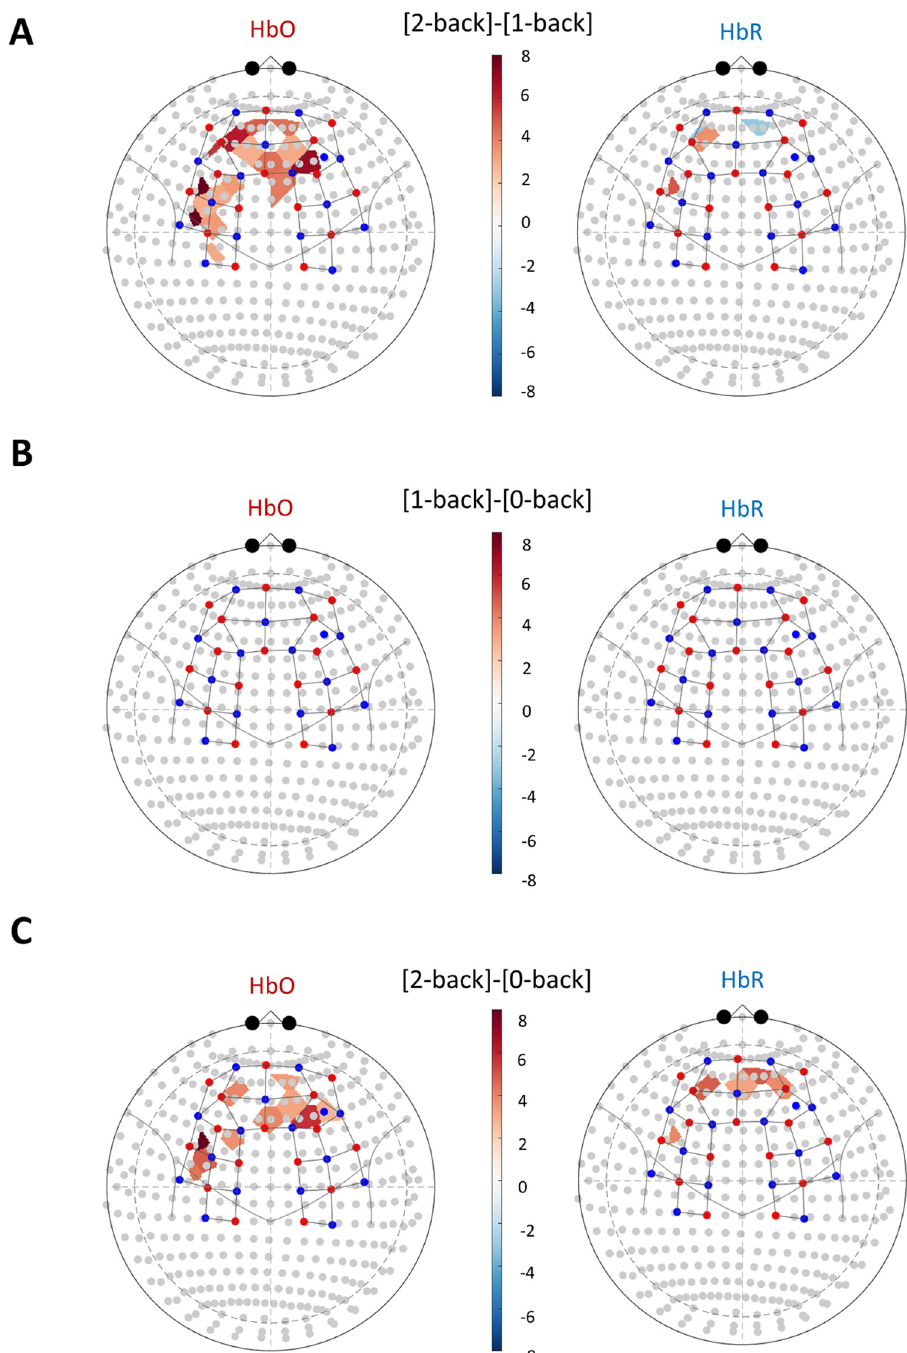
Fig 3. Significant activation of the prefrontal cortex is only detected during the mentally more demanding task with fNIRS. NVC responses were assessed during cognitive n -back stimulation using the functional near-infrared spectroscopy (fNIRS) methodology. Tasks were administered in the following order: 0-back ! 1-back ! 0-back ! 2-back, 0-back being the reference condition, 1-back and 2-back being the tasks with different cognitive demand. Blue dots represent detectors and red dots represent light sources of the fNIRS probe. The 3D probe structure and statistically significant different hemodynamic responses were then projected into the international 10–20 space. t – values are plotted in a color-coded manner to show differences. We observed a statistically significant increase in the oxy-hemoglobin (HbO) levels in the prefrontal cortex (PFC), an increase in the left dorsolateral prefrontal cortex (DLPFC), and a focal increase over the left motor cortex. Data were analyzed using the Brain AnalyzIR software, and